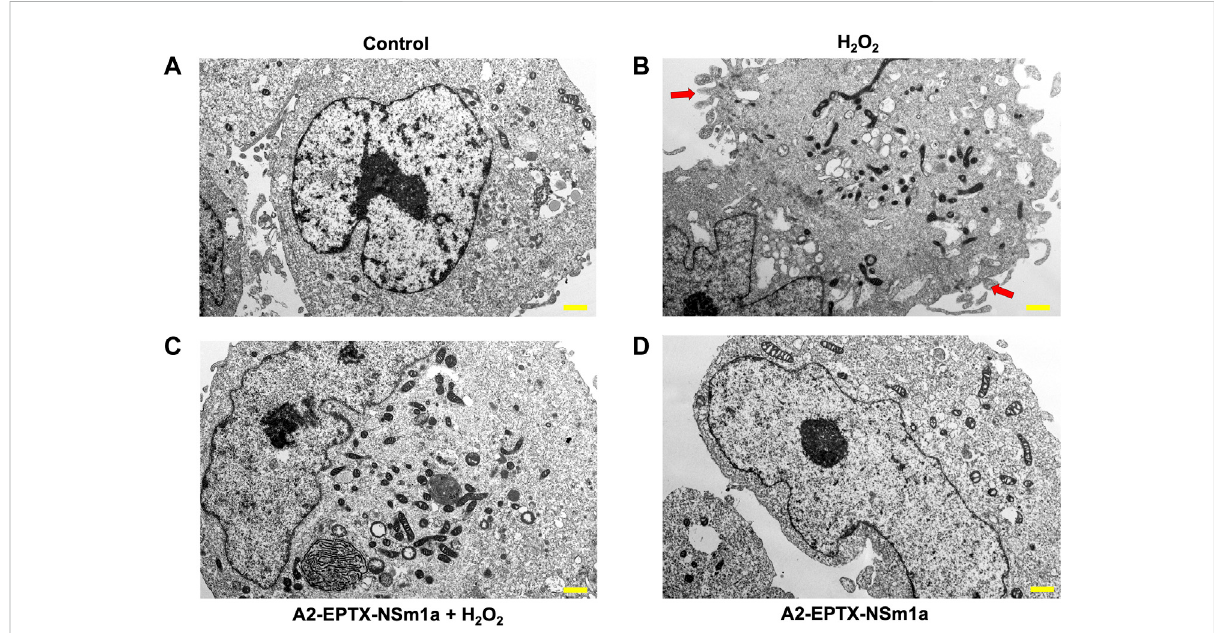
FIGURE 4 RepresentativecellstructureimagesofdifferentiatedSH-SY5Yobservedinanelectronmicroscope.ImageofdifferentiatedSH-SY5Ycellsin (A) untreated group (Control), (B) H 2 O 2 -induced neurotoxicity group, (C) addition of pre-treatment of A2-EPTX-NSm1a following the addition of H 2 O 2 and (D) A2-EPTX-NSm1a alone at 24 h of incubation. Scale bar = 1 μ m. Arrow showed the formation of membrane bubbling due to cell apoptosis induced by H 2 O 2